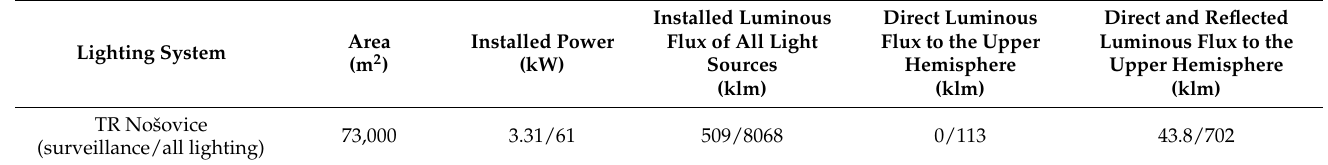
Table 9. Overview of the operational modes of TR Nošovice electrical